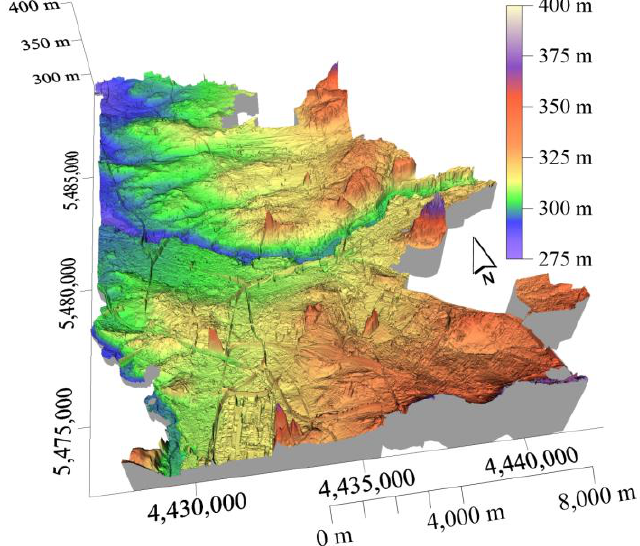
Figure 3. 3D rendering of a digital elevation model (DEM-2) of the Nuremberg investigation area from an airborne laser scan. The spatial resolution is 2 m, while the height accuracy is better than ±0.2 m. The raster file of the DEM-2 is needed to calculate the thickness of the unsaturated zone. Data source: Geobasisdaten © Bavarian Agency for Digitisation, High-Speed Internet and Surveying,